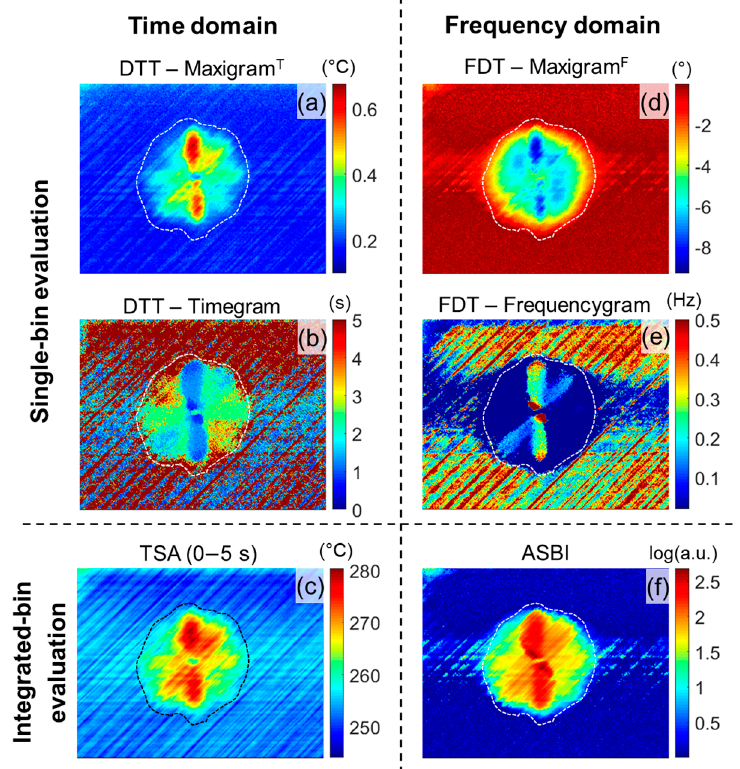
Figure 7. Results of processing techniques for the impacted side of the CFRP BVID coupon: ( a , b ) DTT maxigram T ∆ T max and timegram t ∆ T , max ; ( c ) TSA (0–5 s); ( d , e ) FDT maxigram F ∆ ϕ max and frequencygram f ∆ ϕ , max ; and ( f ) ASBI damage index